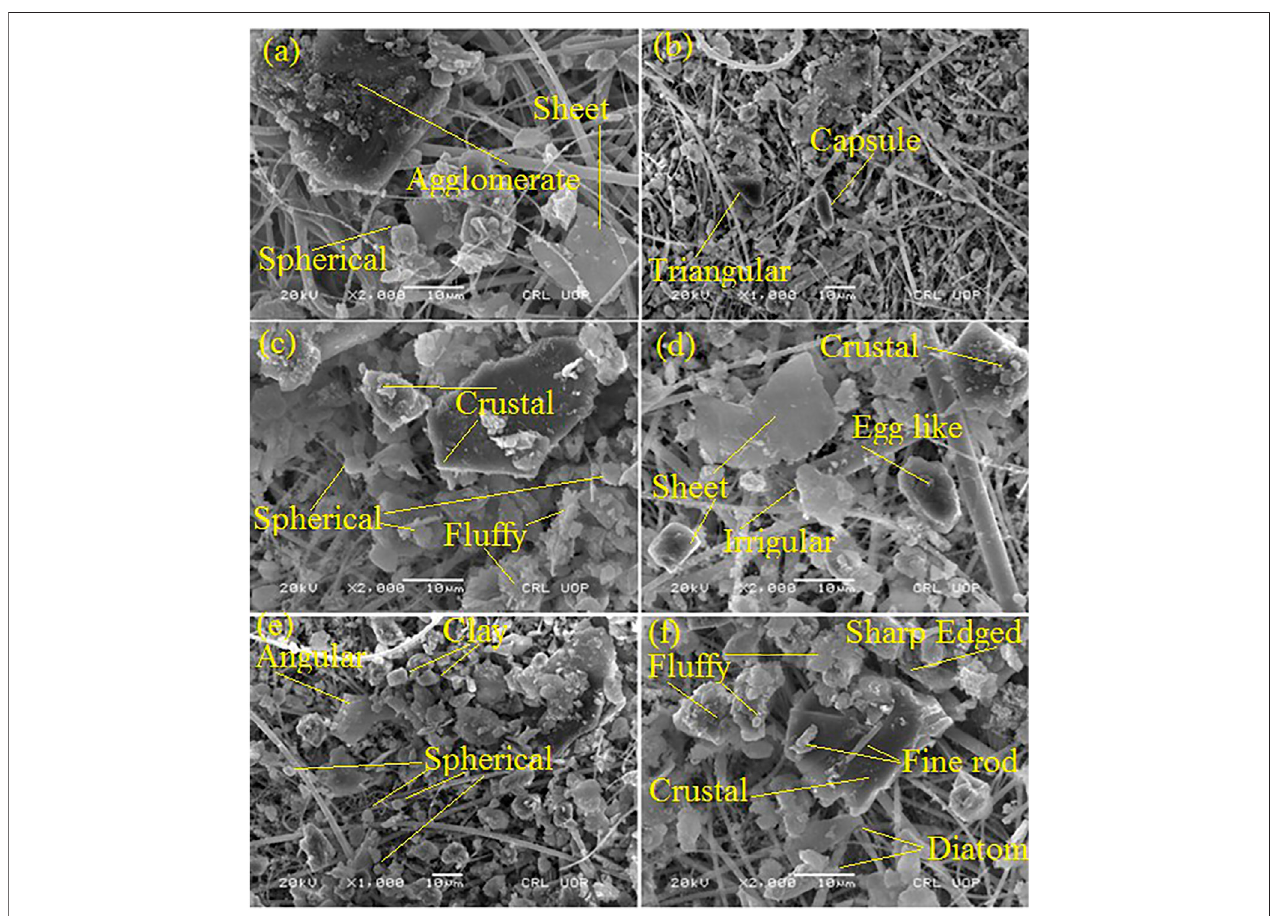
FIGURE 3 | SEM images of collected PM in three locations that is, industrial (A,B) , urban (C,D) , and suburban (E,F) .